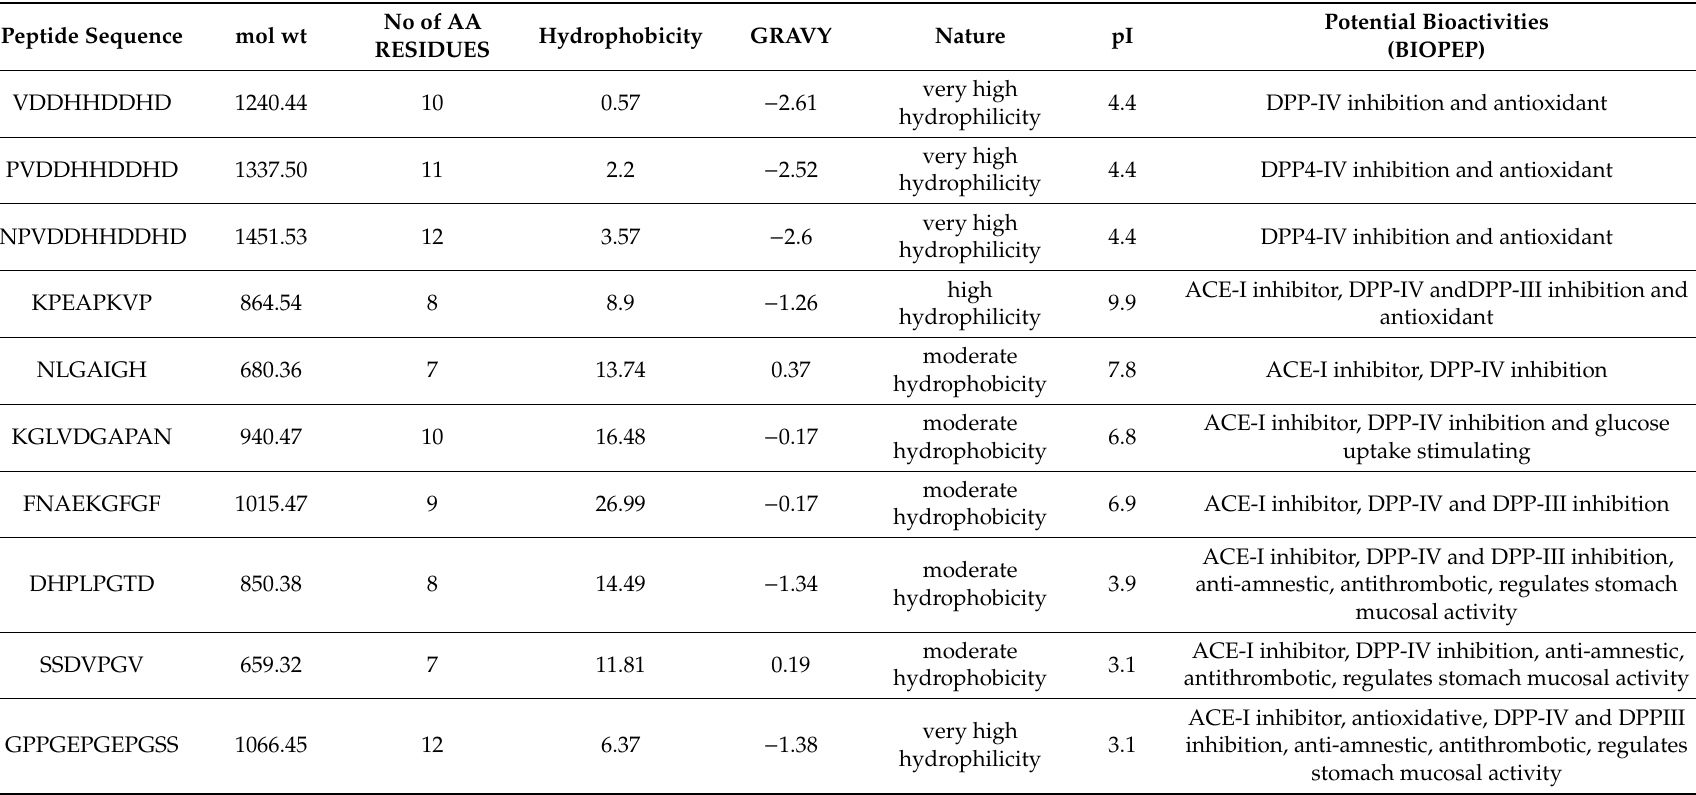
Table 4. Sequence, physicochemical nature and bioactivity of peptide fragments identified using mass spectrometry in the 3-kDa permeate of Killary harbour November 2018 (KHN18) mussel by-product Protamex ® hydrolysate, as analyzed by BIOPEP and Thermo Fisher peptide analysis in silico tools. Peptide